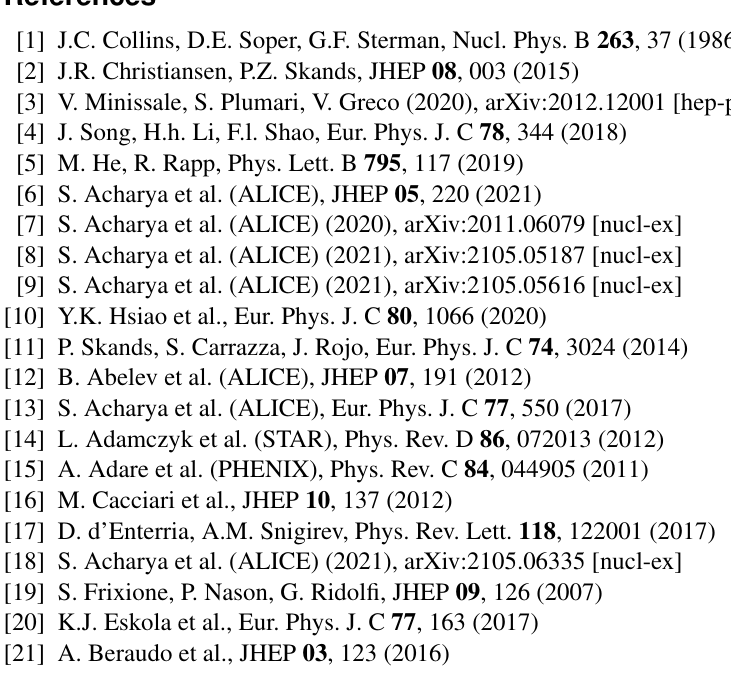
with PYTHIA6 parton shower and EPPS16 [20] parameterisation of the nuclear